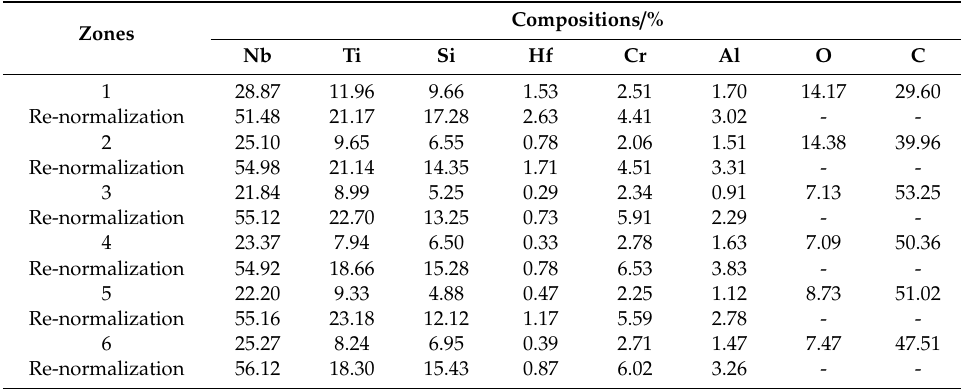
Table 1. Composition of the zones marked in Figure 8, determined by EDS (energy dispersive spectroscopy) mapping